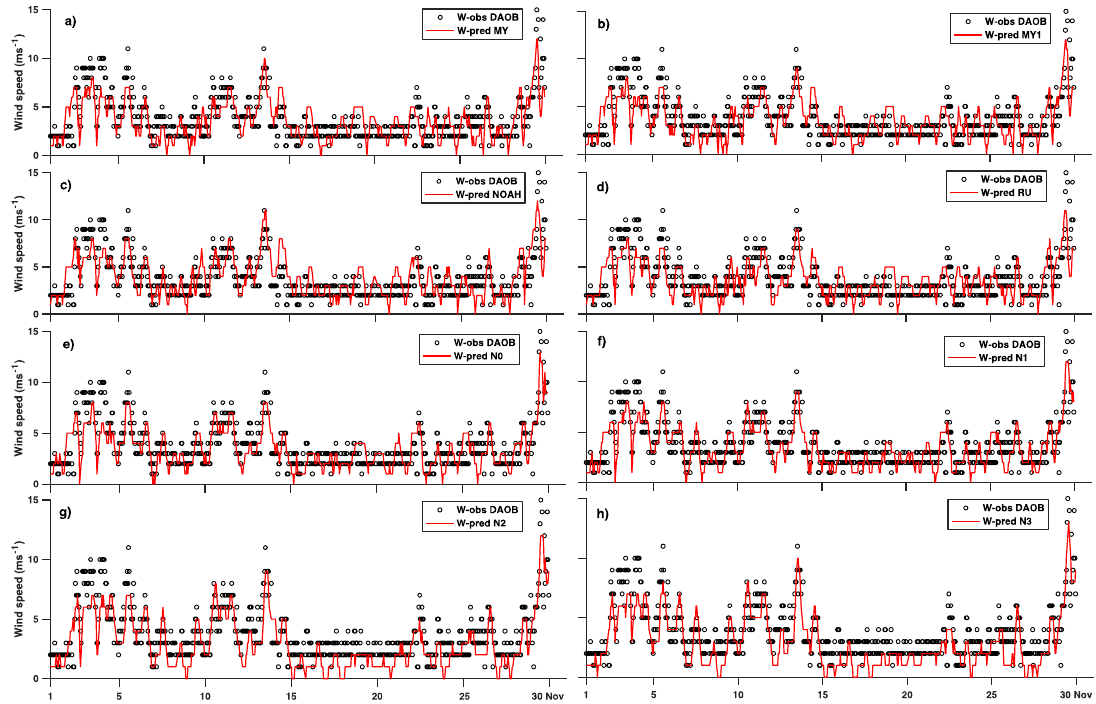
Figure 7. Time series of wind speed observed at DAOB meteorological station versus wind speed predicted by MY ( a ), MY1 ( b ), NOAH ( c ), RU ( d ), N0 ( e ), N1 ( f ), N2 ( g ), and N3 ( h ) simulations.